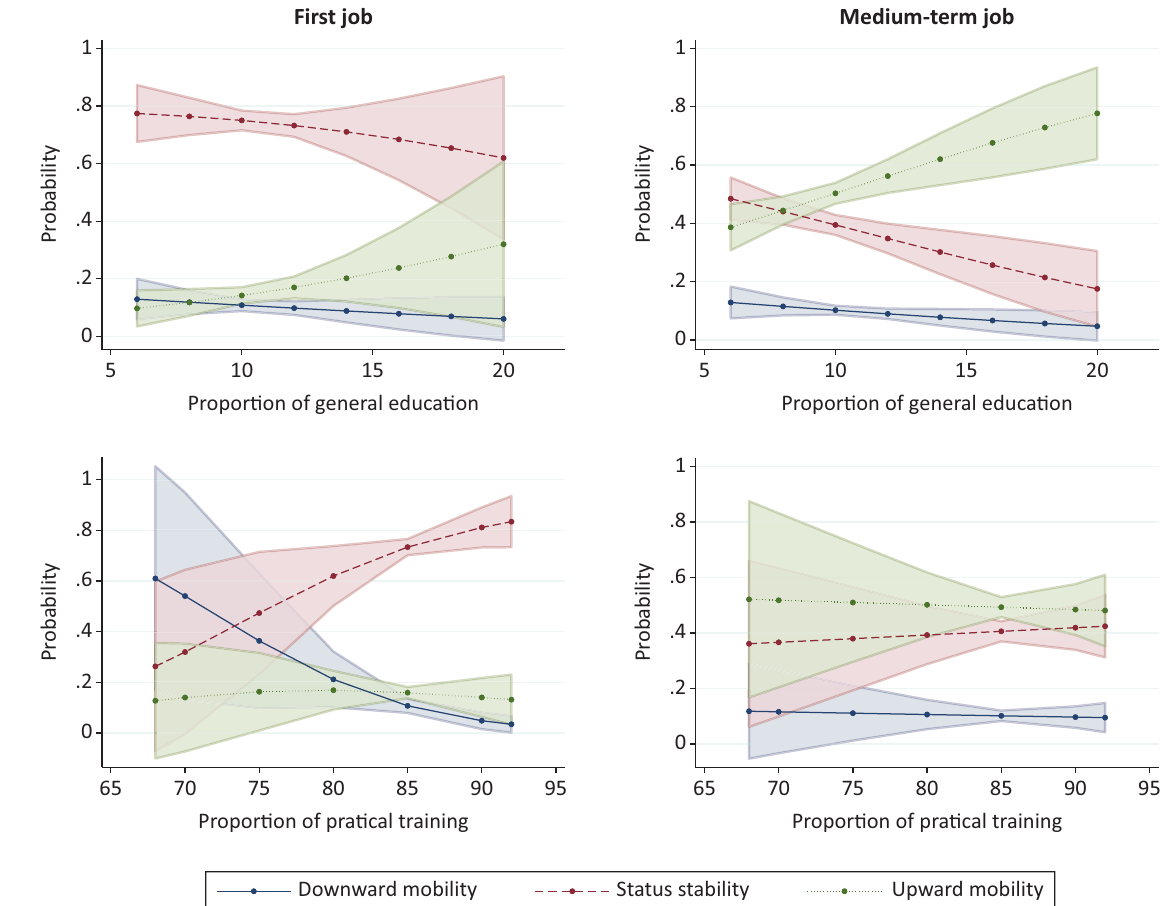
Figure 1. Predicted mobility based on the proportion of general education and practical occupation‐specific training at labour market entry and during the early career. Note: Predicted margins with 95% confidence intervals based on Model 2 in Table 3 and Model 5 in Table 4. Source: Own calculations based on TREE (first cohort). positive effect diminishes and is no longer